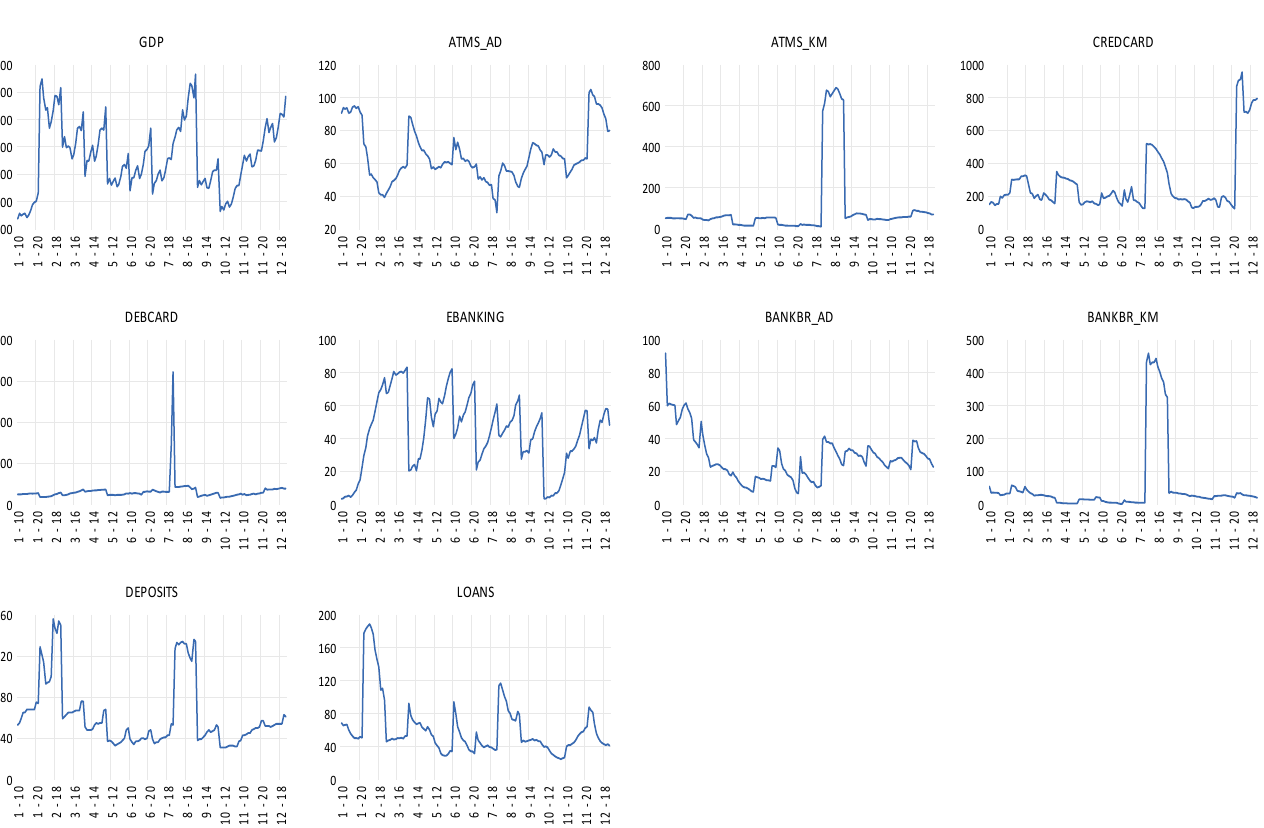
Figure 1. Evolution of selected indicators in CEECs during 2010–2021. Sources: Author’s processed data from IMF, Financial Access Survey (FAS) database. Available at: https://data.imf.org/regular.aspx?key=61063967 (accessed on 2 October 2022) .